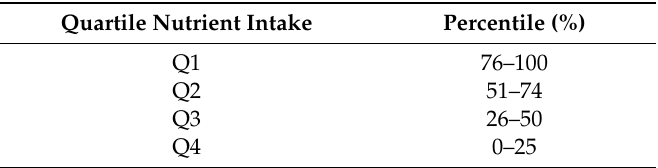
Table 2. Nutrient Quartiles for Receiver Operating Curve